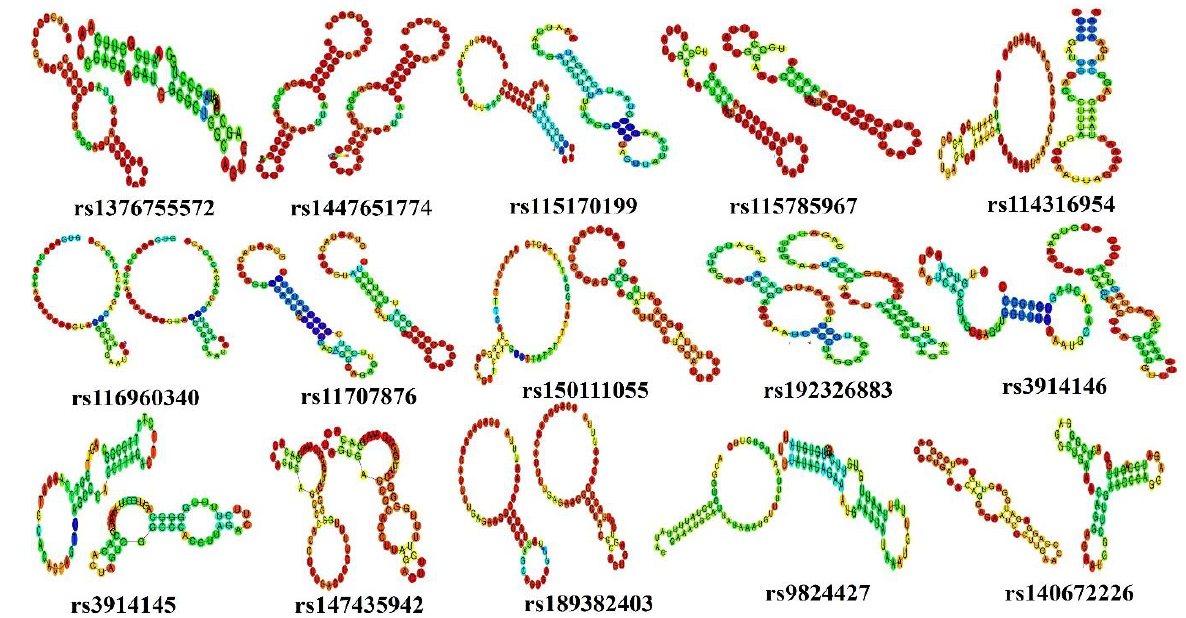
Figure 4. Comparison of structures of wild and mutated mRNA of 3 ′ UTR SNPs through RNAfold.